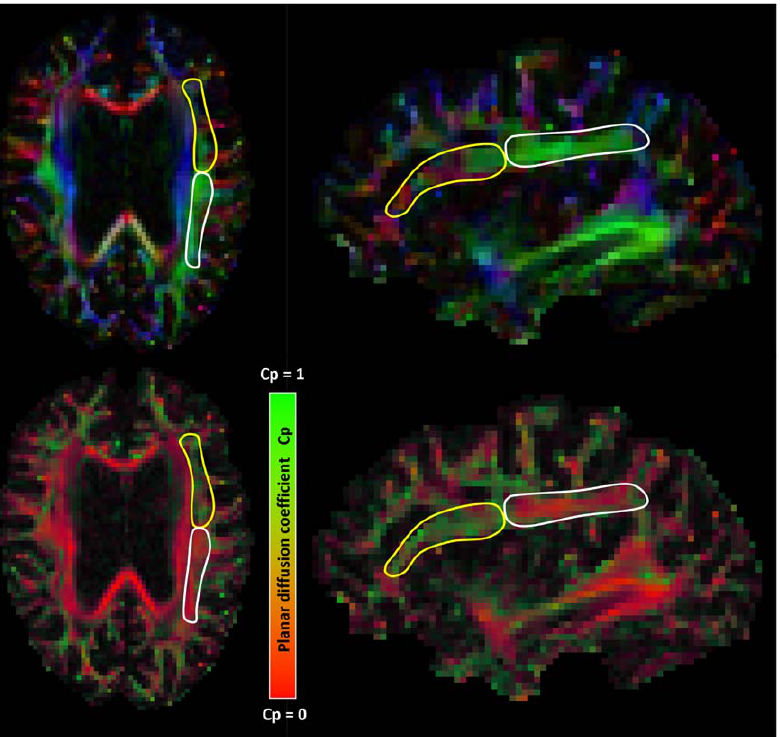
Figure 4. Crossing fiber regions in the superior longitudinal fasciculus (SLF). Sub-regions of the SLF marked on a directionally encoded color map (top row) and planar diffusion coefficient encoded (Cp) map (bottom row). The planar diffusion coefficient ranges from zero to one and is relatively high in voxels were the tensor has a disc-like shape, which is typically the case when two fiber populations ‘‘cross’’. The white line marks a sub- region of the SLF containing voxels with relatively few ‘‘crossing fibers’’, which is reflected by a Cp close to zero. By contrast, the more anterior sub-region of the SLF, marked in yellow, contains relatively many voxels with ‘‘crossing fibers’’, due to crossing with the cortico-spinal tract and/or laterally projecting fibers of the corpus callosum. This is reflected by a Cp closer to one.